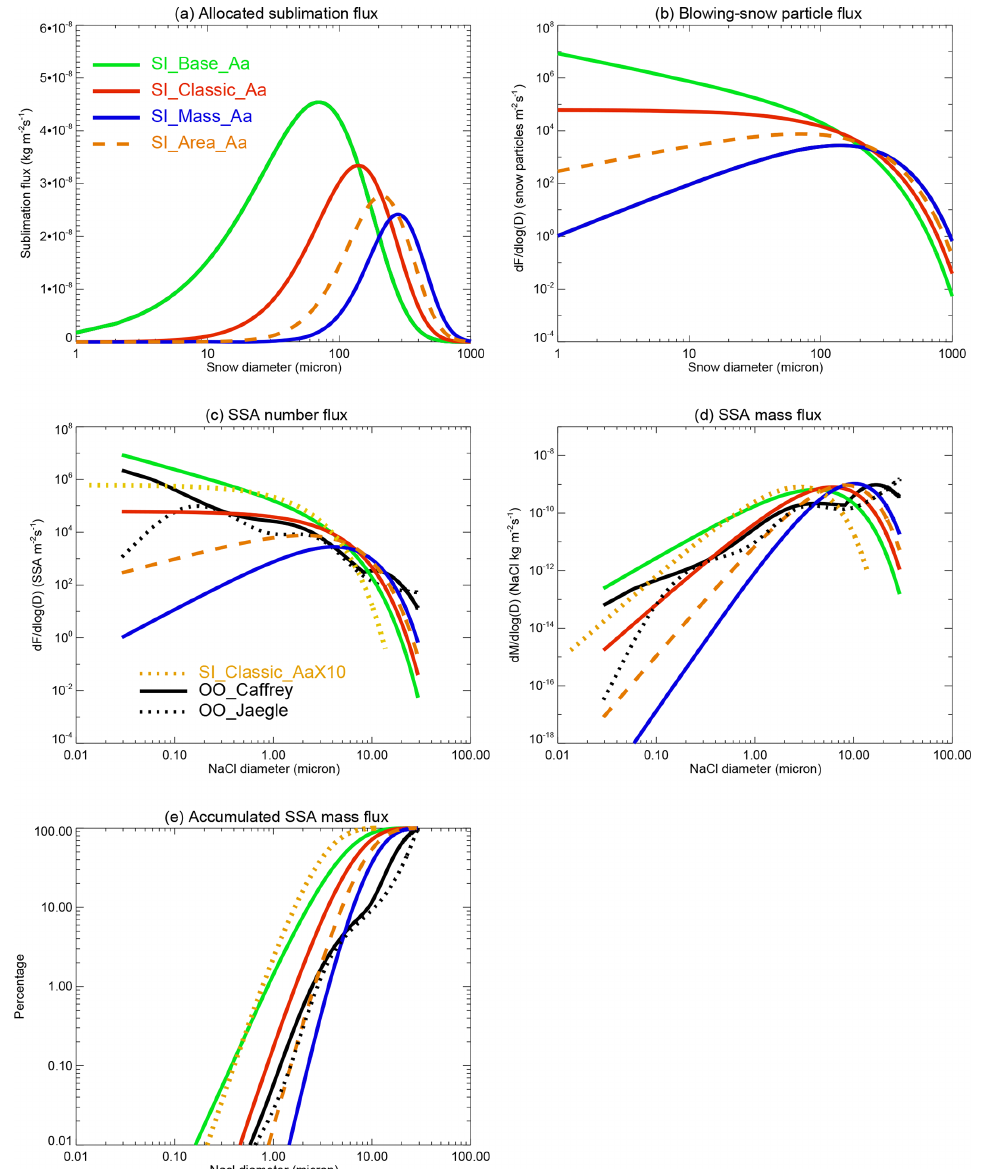
Figure 8. (a) Allocated sublimation fluxes across different snow size bins (with a bin interval of 1µm) in each experiment. Note that the bulk sublimation flux used for allocation is calculated under conditions of wind speed = 12ms − 1 , temperature =− 10 ◦ C, RH (with respect to ice) = 80% and snow age = 0d. (b) Converted blowing-snow-particle production flux. (c) Corresponding SSA number production flux. Note that the conversion is under a fixed snow salinity of 0.06psu and assuming one SSA from one saline blown-snow particle. Two open-ocean sea spray fluxes under the same wind speed of 12ms − 1 (SST = 5 ◦ C for OO_Jaeglé) are shown for comparison. (d) Same as (c) apart from for the mass flux. (e) Accumulated mass flux